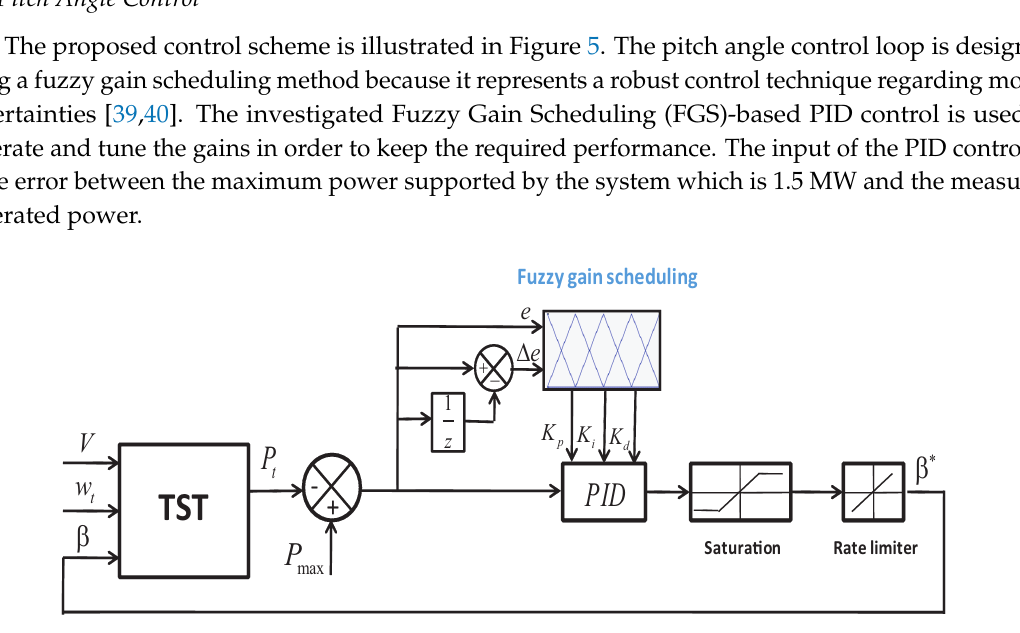
Figure 5. Fuzzy Gain Scheduling (FGS)-Proportional Integral Derivative (PID) based pitch angle control